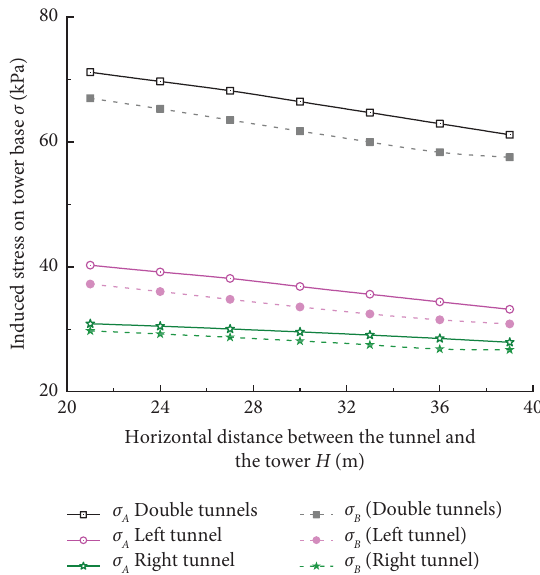
Figure 8: Te induced stress under diferent horizontal between the tunnel and